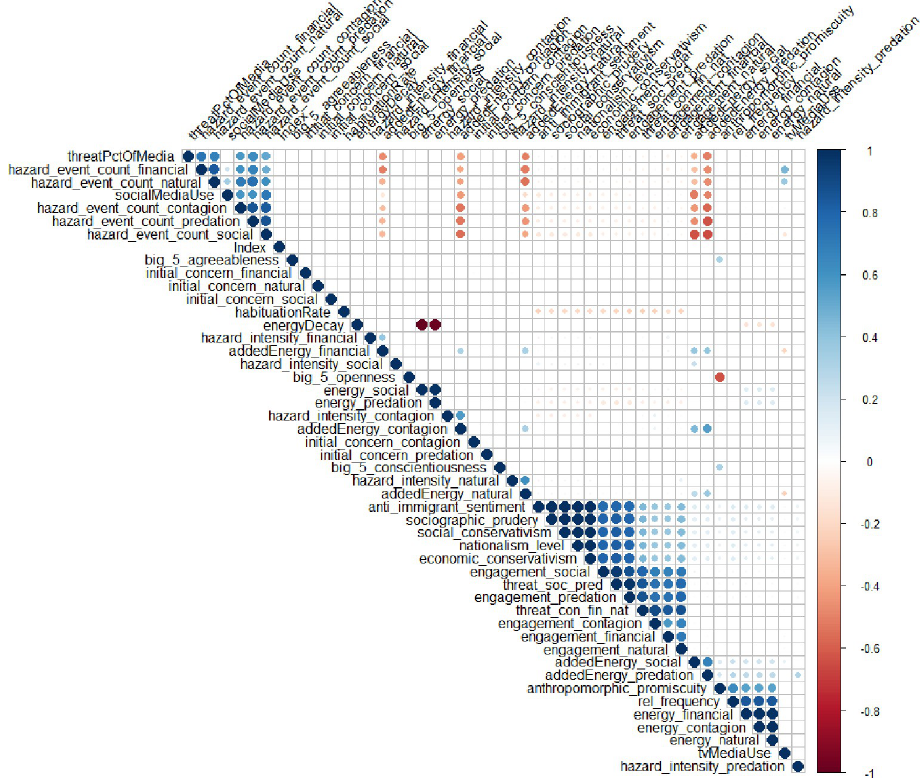
Fig 16. Correlation heatmap of simulation output results.